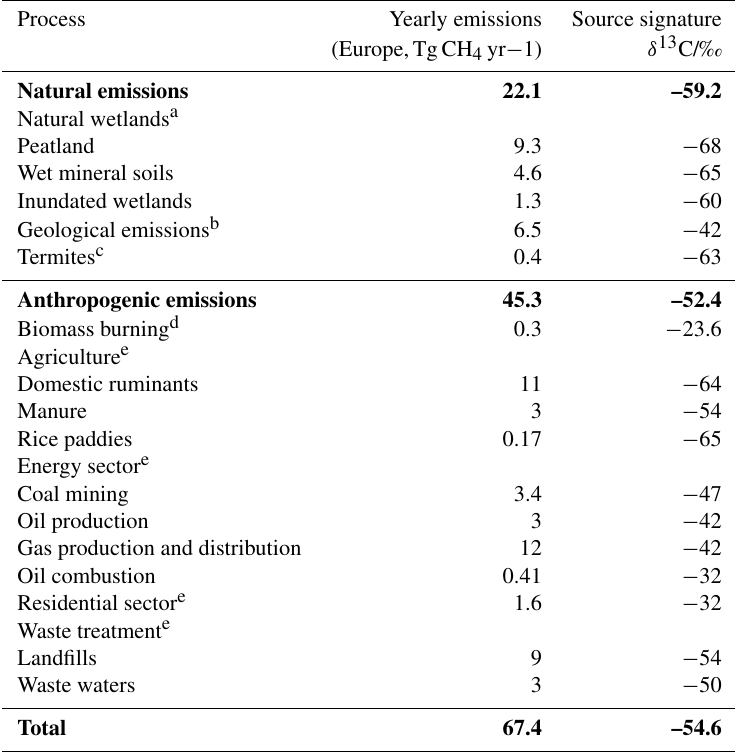
Table 1. European CH 4 emissions and isotope source signatures ( δ 13 C, δ D) for the different source categories used in TM5. Bold numbers refer to the total of natural, anthropogenic and all emissions,